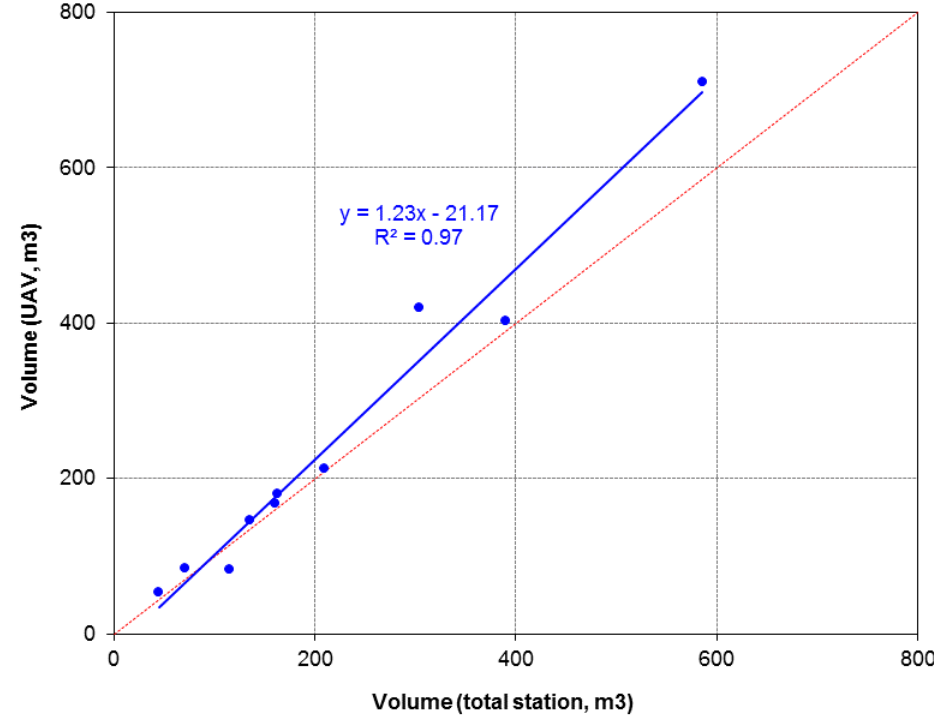
Figure 9. Regression of sediment wedge volumes estimated by the aerophotogrammetric and topographic methods for ten check dams (Sierra de Los Donceles forest, Castilla La Mancha, Spain).